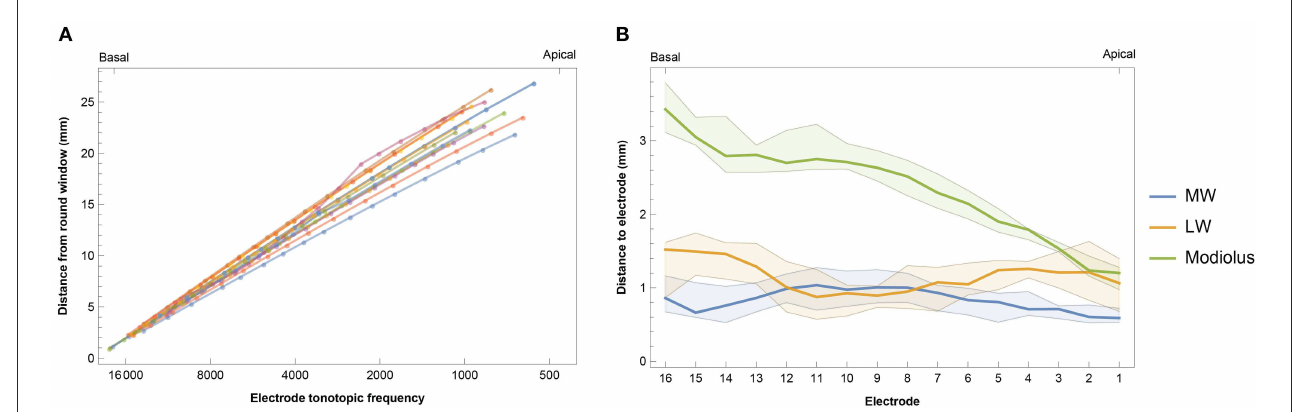
FIGURE3 (A) Intracochlear insertion depth for 14 subjects in relation to the calculated tonotopic location of each electrode. Insertion depth was calculated as the distance from the round window to the nearest point on the lateral wall for each contact. (B) Median intracochlear distances between electrodes and the medial wall (MW), lateral wall (LW), and center of the modiolus. Bands indicate the first and third quartiles.